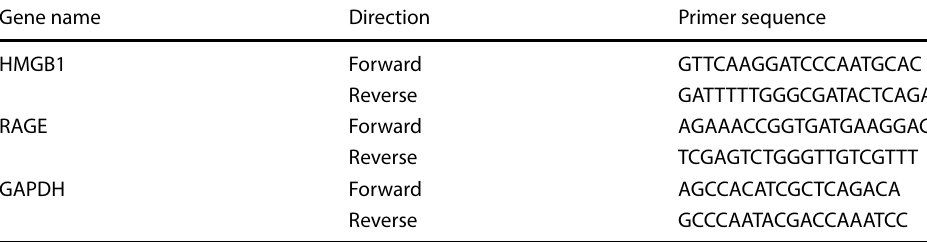
Table 1 Primers used for qRT– PCR